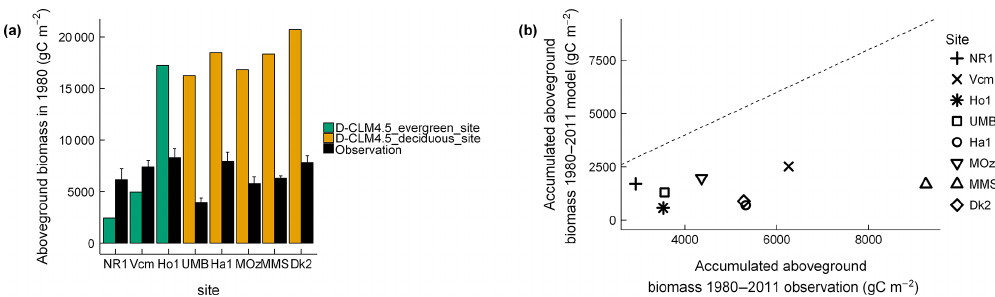
Figure 2. Comparisons (a) between observed and modeled (D-CLM4.5) aboveground biomass in 1980 and (b) between observed and modeled (D-CLM4.5) accumulated aboveground biomass between 1980–2011. Dashed line is 1 : 1 relationship between observations and model. Observations (estimates of aboveground biomass from tree-ring data) for the Ho1 and Ha1 sites are from Dye et al. (2016), whereas for the rest of sites observations were obtained following the methodology described in Alexander et al.